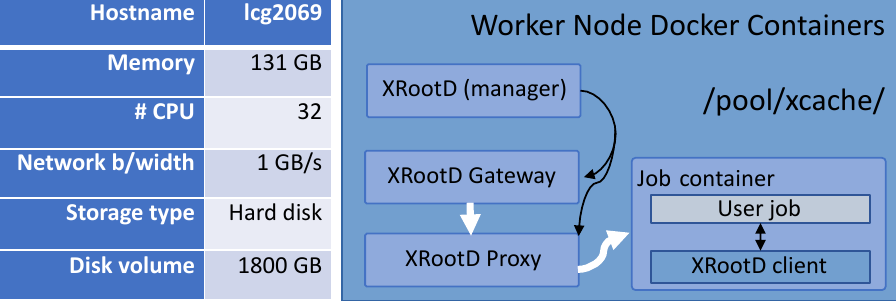
Figure 3: Specification and schematic of RAL worker node